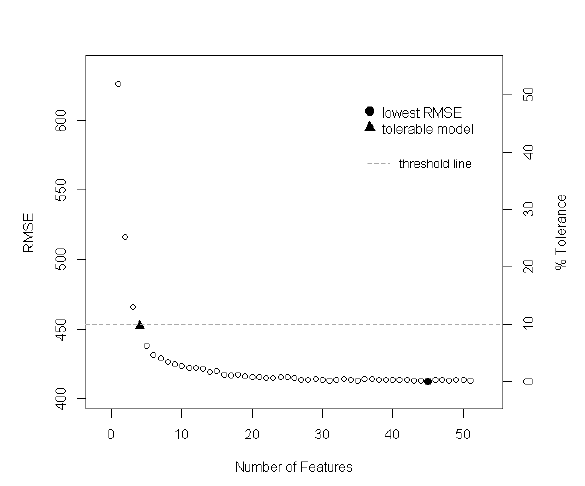
Figure 5 - Optimal (circle) and Tolerable (triangle) Model